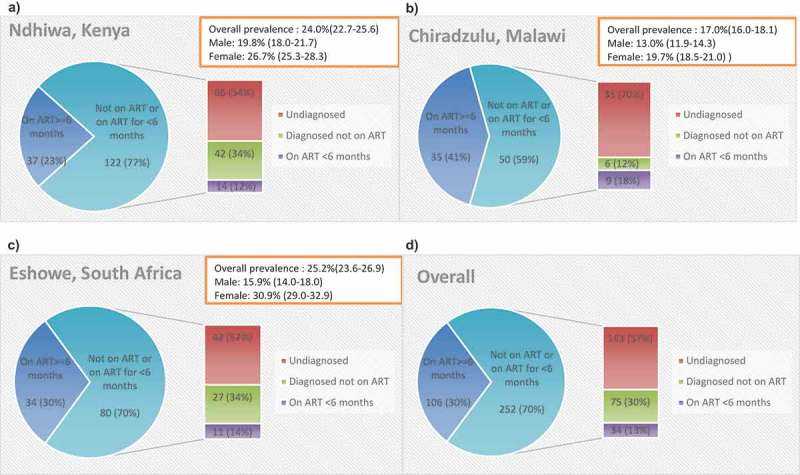
Showing distribution of 358 individuals with advanced HIV disease by ART status for each survey and overall.(a) Kenya: ART eligibility at the time of survey was CD4 ≤ 350 cells/µl or WHO Stage 3 or 4 disease and ART prophylaxis for pregnant and breast-feeding women if CD4 > 350 cells/µl (Option A)(b) Malawi: ART eligibility at the time of survey was CD4 ≤ 350 cells/µl or WHO Stage 3 or 4 disease and lifelong ART for pregnant and breastfeeding women (Option B+)(c) South Africa: ART eligibility at the time of survey was CD4 ≤ 350 cells/µl or WHO Stage 3 or 4 disease and ART for pregnant and breastfeeding women until cessation of breastfeeding (Option B).